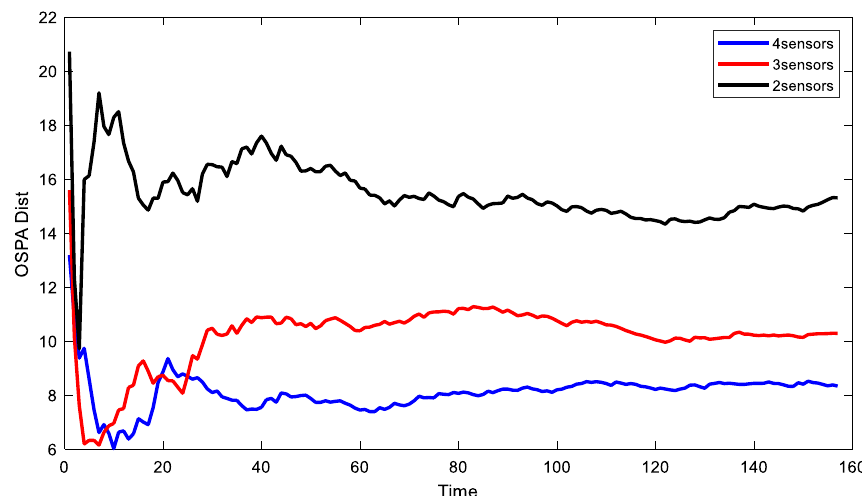
Fig. 11 Comparison of fusion results of different numbers of sensors